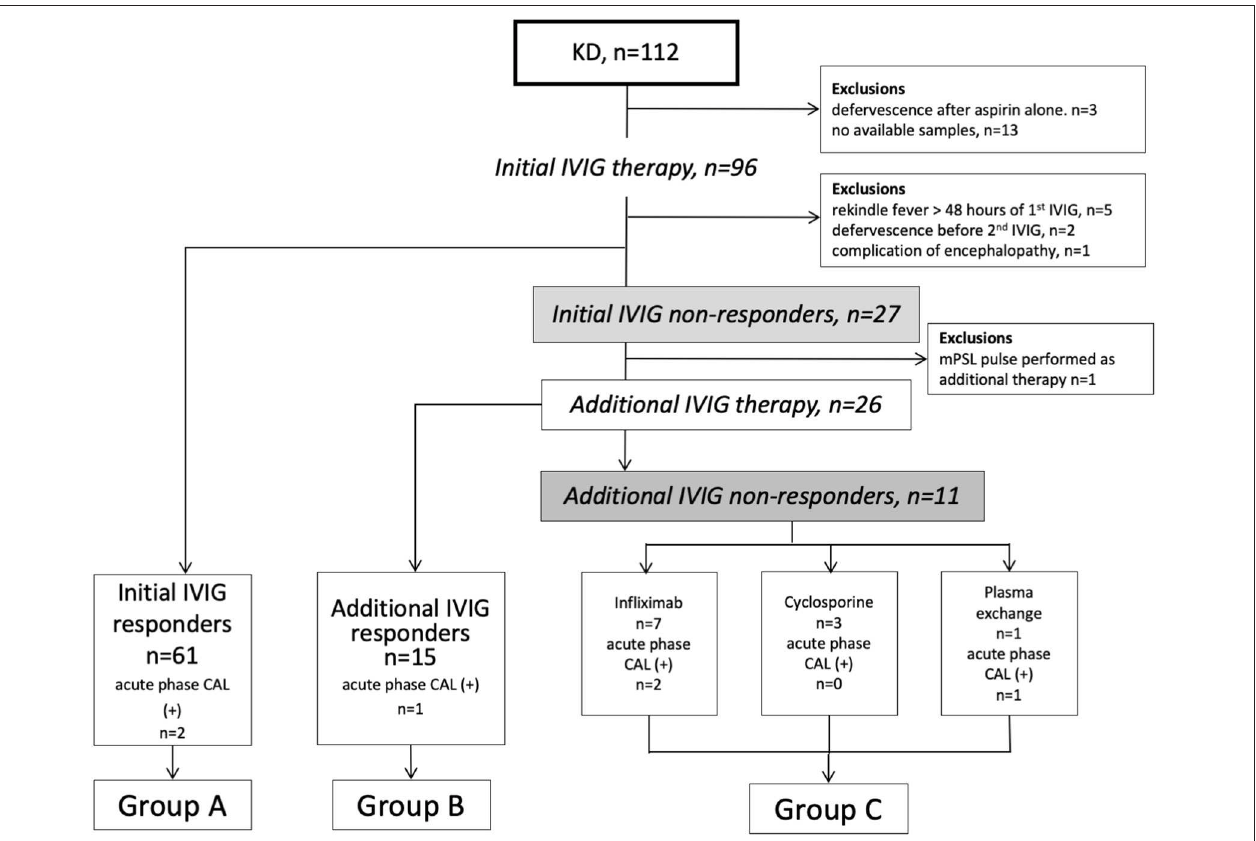
FIGURE 1 | Flow chart of KD patients in this study. KD, Kawasaki disease; IVIG, intravenous immunoglobulin; CAL, coronary arterial lesion; mPSL, methylprednisolone.